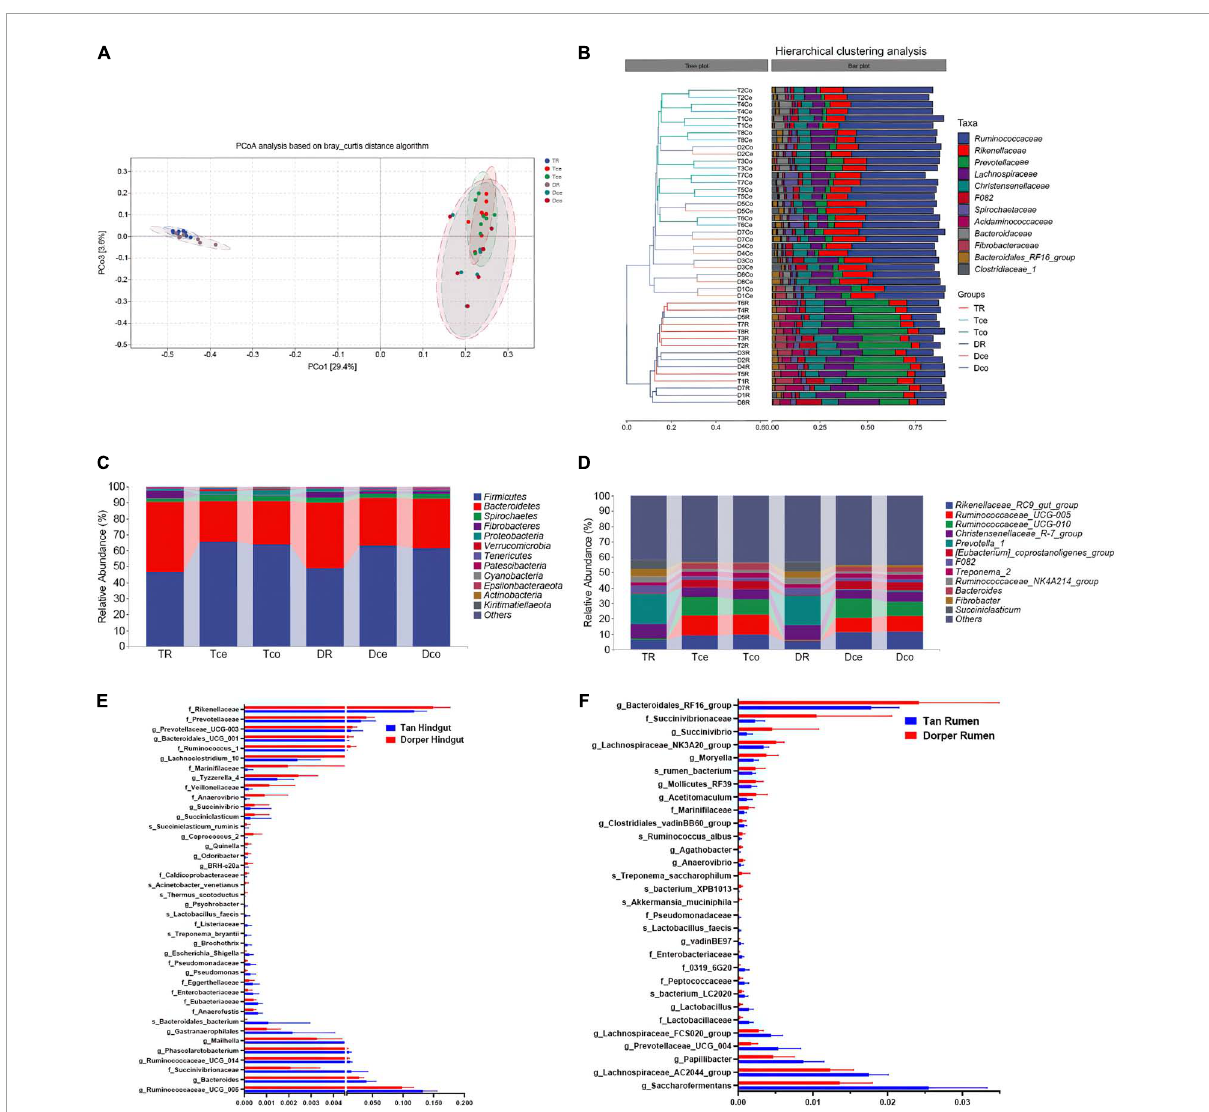
FIGURE3 Microbial composition and ratio. (A) Principal coordinate analysis (PCoA) based on all samples. (B) The hierarchical tree shows the UPGMA clustering result. The abscissa indicates the distance between samples, the number after the group abbreviation represents the individual number, and the branch length indicates similarity. On the right is the stacked histogram of the top 10 abundant bacterial families in the sheep intestine. The abscissa indicates the proportion of bacteria. (C) The phylum-level microbial composition of each intestinal segment. (D) The genus-level microbial composition of each intestinal segment. (E) The ratio of key rumen microorganisms among breeds ( P- value < 0.05). (F) The ratio of key hindgut microorganisms among breeds. ( P- value <